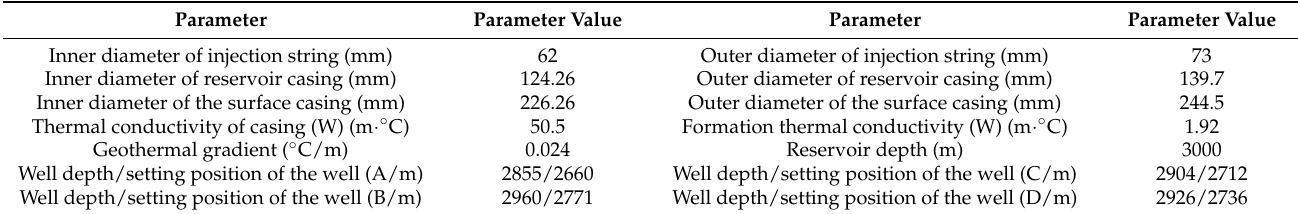
Table 3. Basic parameters of CO 2 injection strings in the